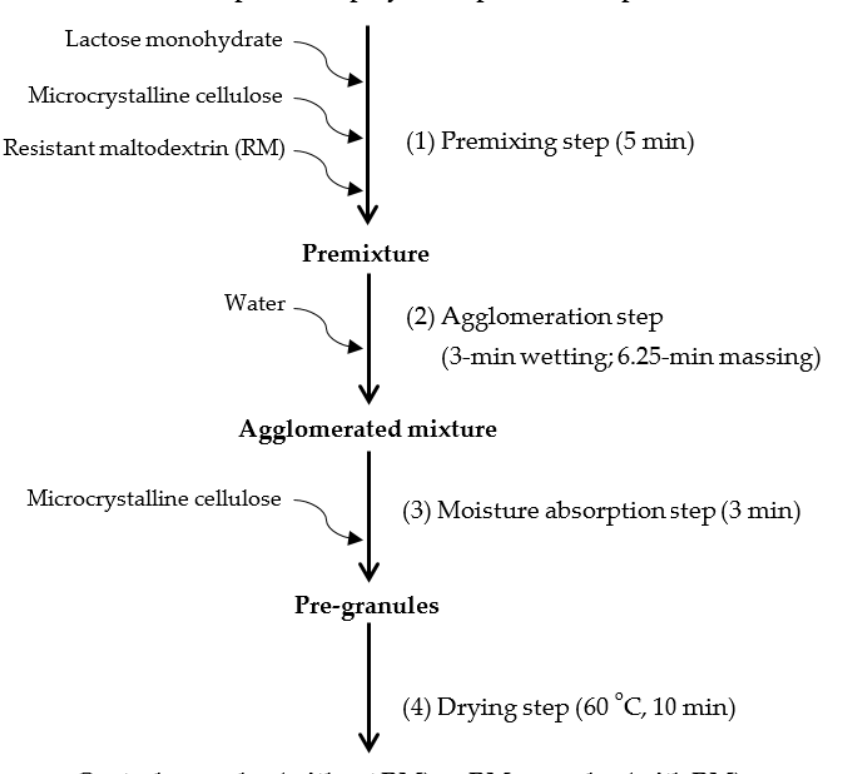
Figure 1. Experimental scheme of high-shear granulation process performed in the study.